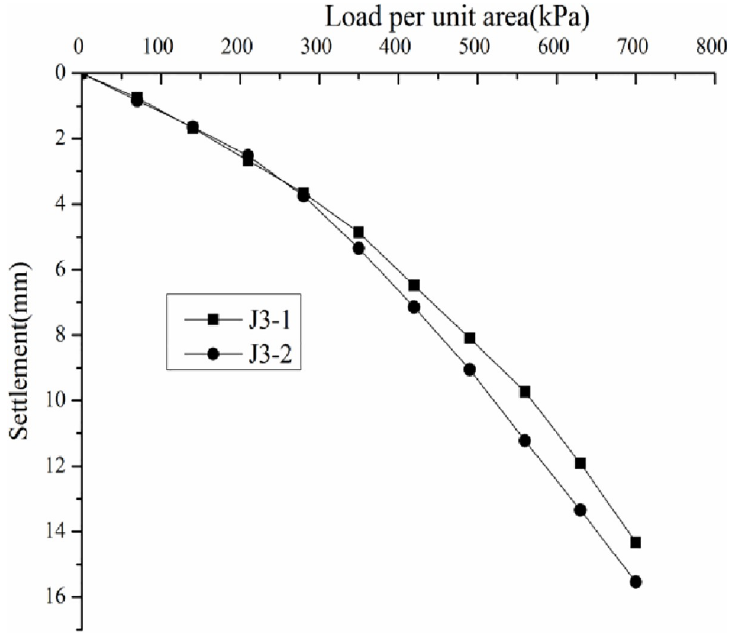
Fig 17. Load–settlement curves for the plate loading tests of J3.